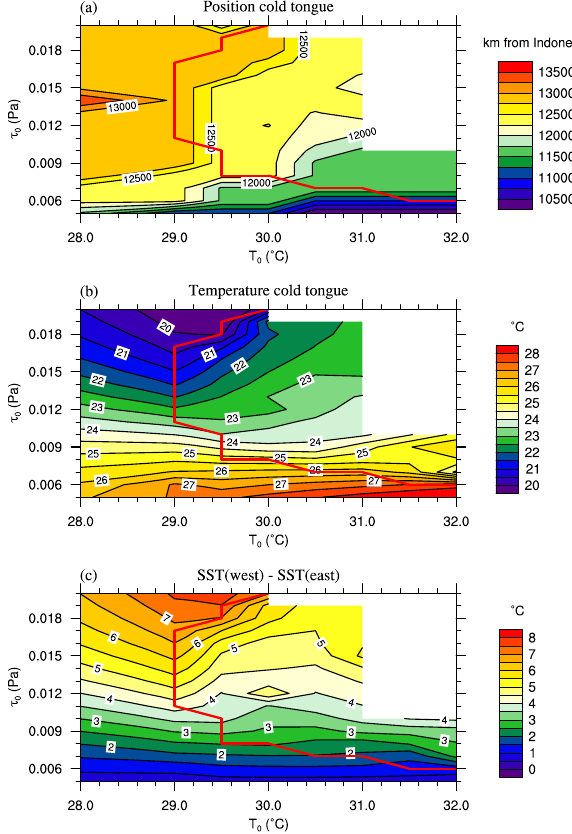
Fig. 4. Effects of changing the external wind stress τ 0 and the radi- ation equilibrium temperature T 0 on the climatology (i.e., the time- mean) of the tropical Pacific. (a) Time-mean zonal position of the cold tongue (in km from Indonesia) at the equator as a function of τ 0 and T 0 . (b) Time-mean temperature of the cold tongue as a func- tion of τ 0 and T 0 . (c) Time-mean zonal SST difference between west and east Pacific at the equator as a function of τ 0 and T 0 . The red line in the contour plots divides the area into regions with and without ENSO variability. Left of the red line there is no ENSO variability. White area: the model yields unphysical results.